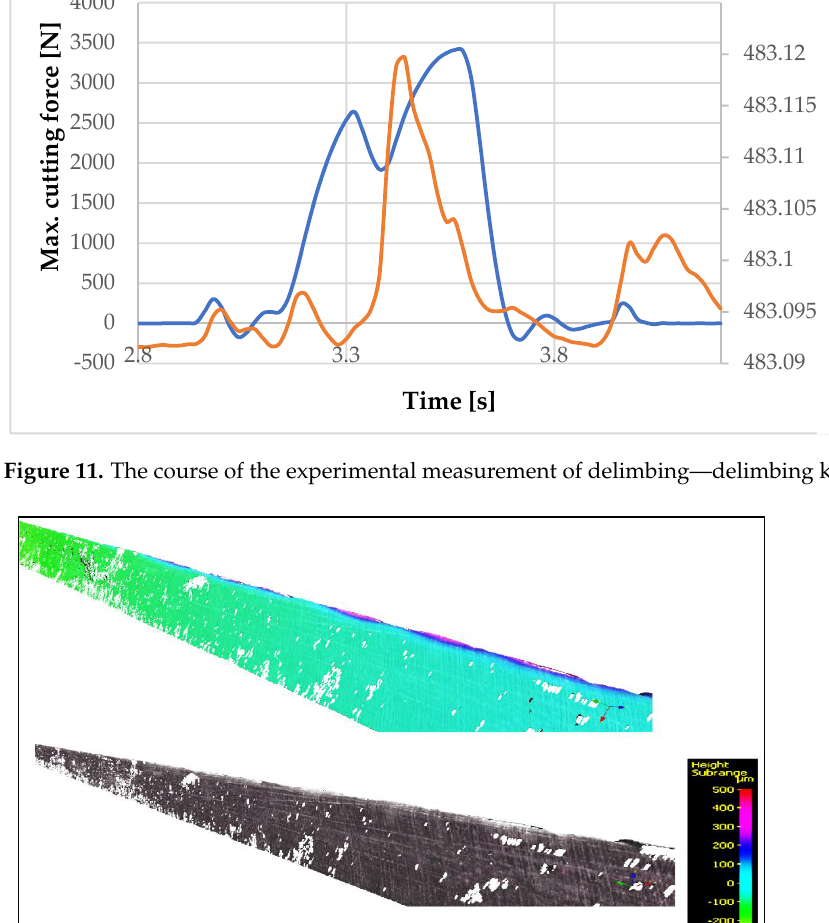
Figure 12. Cutting edge wear — knife No. 3 — Norway spruce. 4. Conclusions The cutting edge was evaluated using the Alicona Infinite Focus device. It is a highly accurate, fast and flexible optical 3D measuring system that can also evaluate the micro- structures of a material. In light of the achieved results of the evaluation of the cutting edge wear using the material DIN 58SiCr8/WNr, it is recommended to use a cutting edge radius of the delimb- ing knife in the range of 0.012-0.0025 mm at the cutting edge ∢ 155° with a flank angle ∢ α 4°. Although, in practice, it is not possible to use such a large cutting edge radius in terms of durability, this was necessary for testing in laboratory conditions to achieve higher cut- ting forces and evaluate wear. Higher cutting forces are necessary to ensure sufficient de- limbing of diameters in the interval of 0–60 mm of branches. The delimbing process in